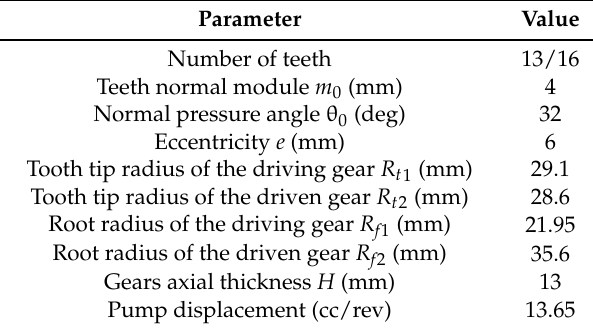
Table 3. Parameters of the gears.